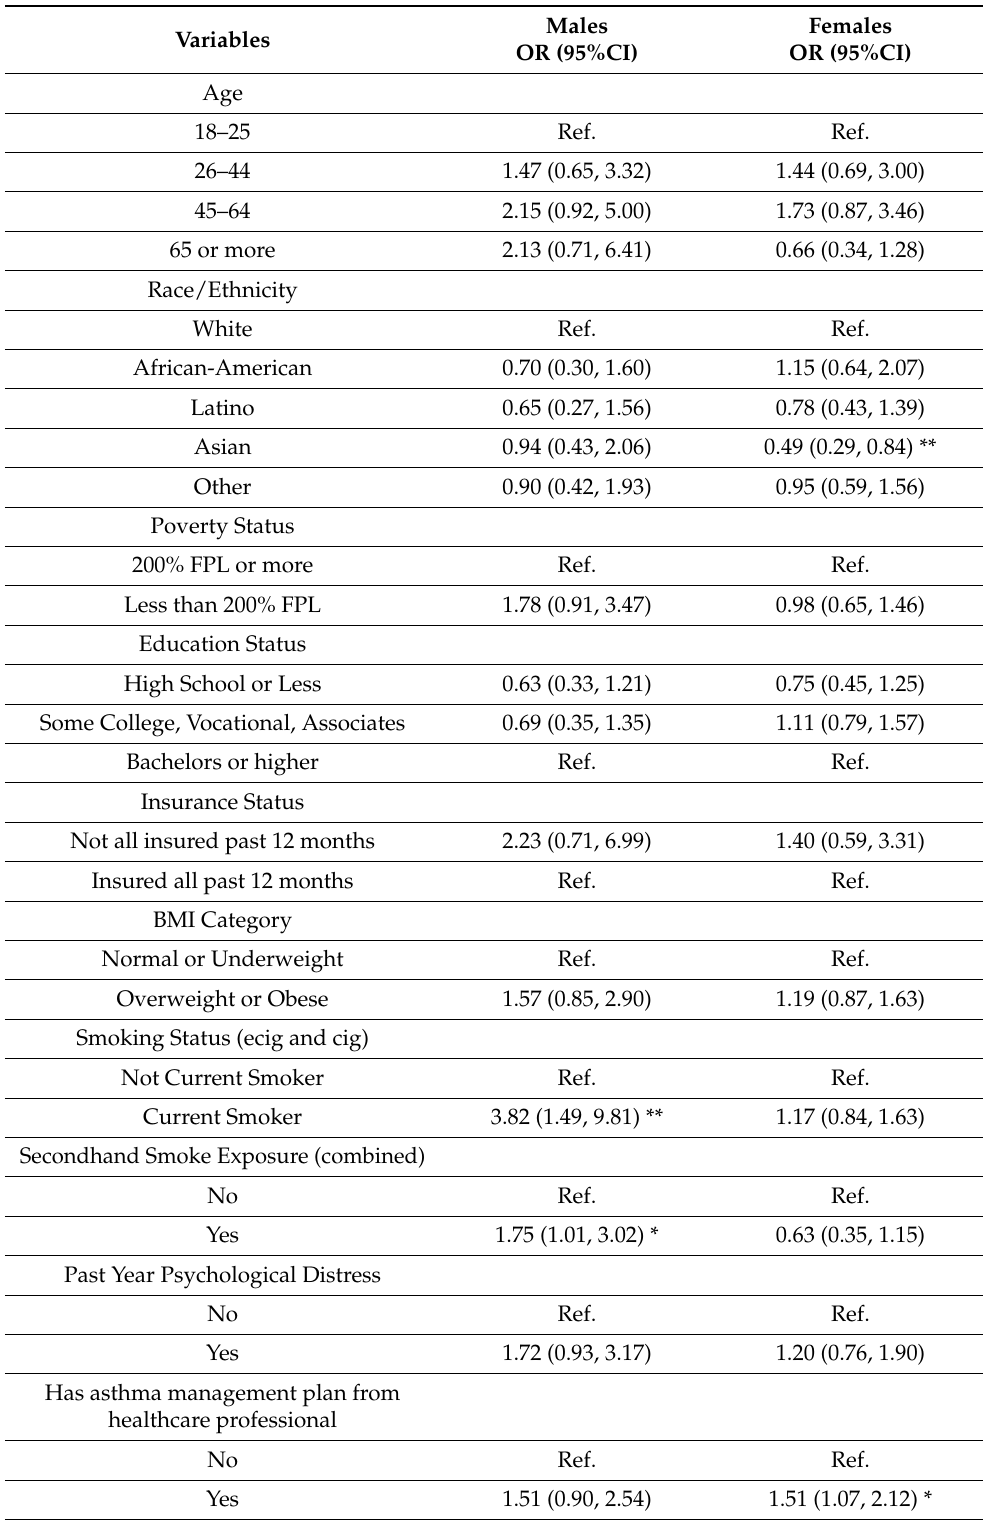
Table 3. Odds ratio (OR) and 95% confidence interval (CI) of asthma attack in the past 12 months, by sex †